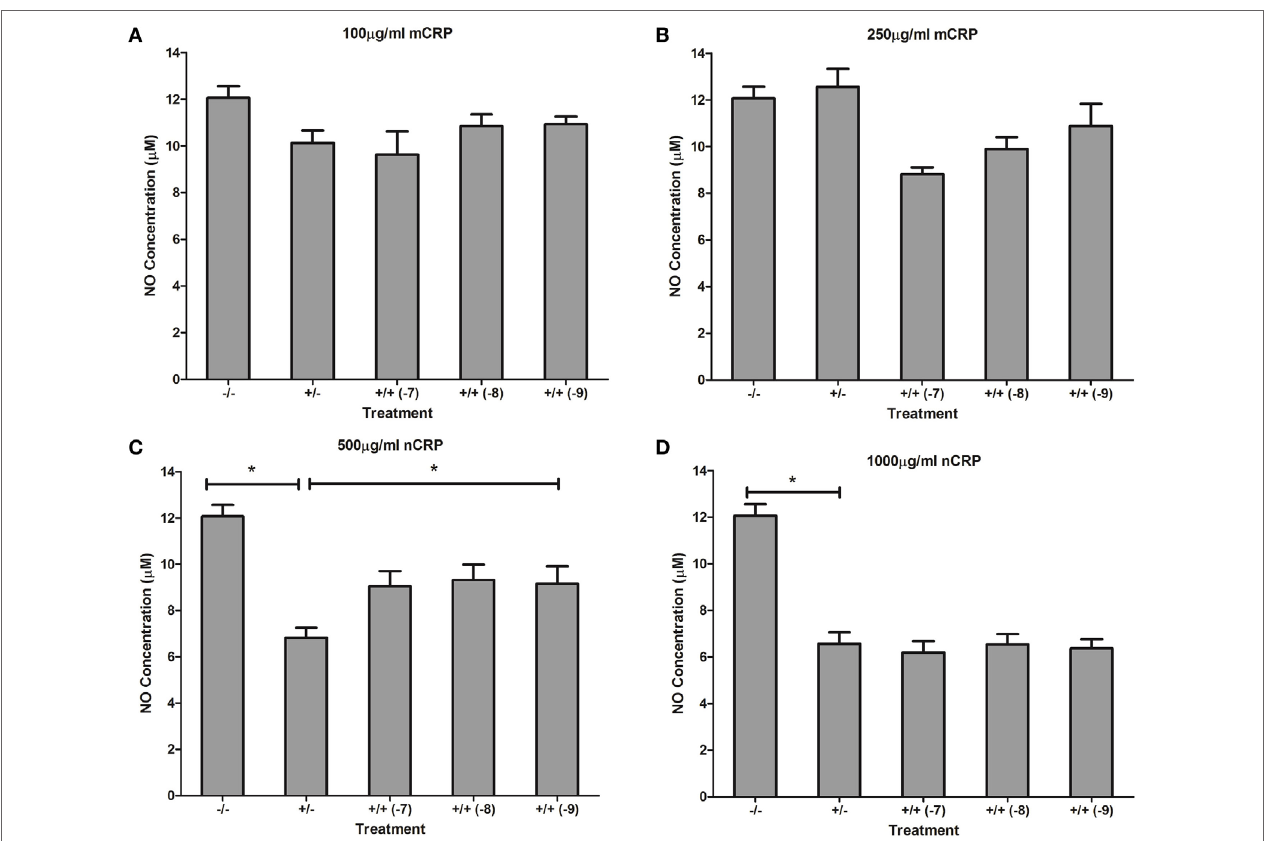
FigUre 9 | Effect of estrogen on CRP-mediated NO production by unactivated U937 macrophages. Estrogen had no effect on NO production when co-supplemented with mCRP in unactivated (a,B) macrophages. However, estrogen reversed the nCRP-mediated reduction in NO production by unactivated macrophages treated with low (c) but not high (D) levels of nCRP. − / − represents the untreated negative control with no CRP or estrogen supplementation. + / − represents treatment with CRP alone. + / + represents cells treatment with both CRP and estrogen. The number in parentheses indicates the